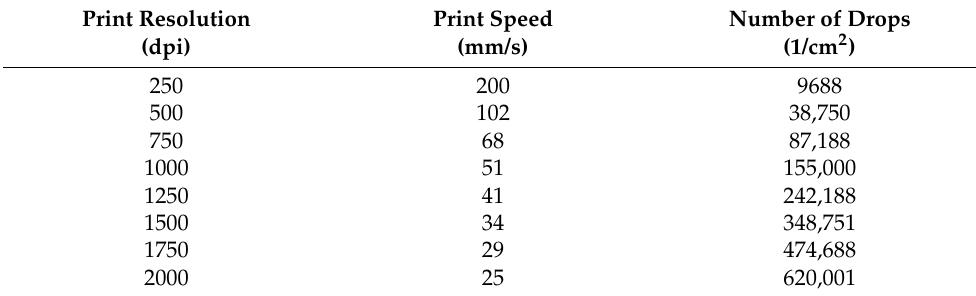
Table 4. Used resolutions for calibration and corresponding calculated required print speed and number of drops related to an imprinted area of 1 cm 2 , dpi = drops per